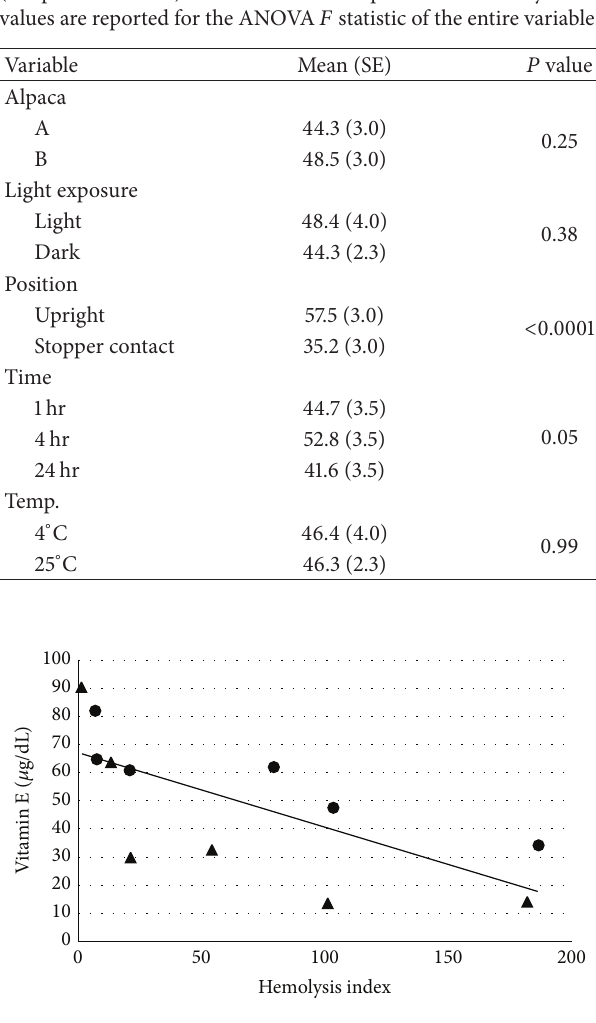
Table 1: Least squares means serum vitamin E concentrations ( 𝜇 g/dL) in 2 adult male alpacas after exposure of whole blood to the following conditions: exposure to fluorescent room light (light exposure: light or dark), contact with the rubber tube stopper